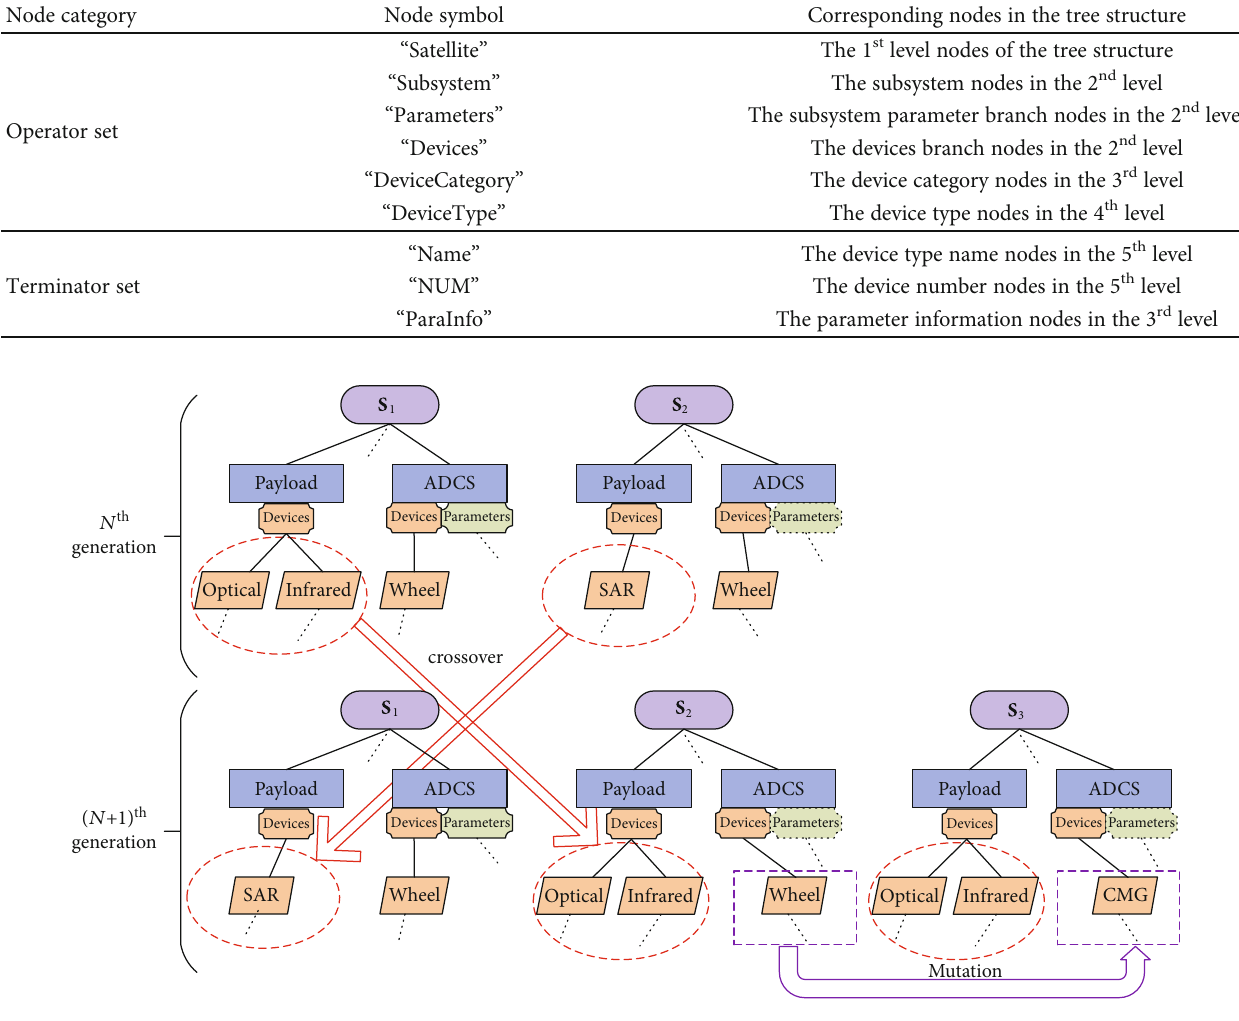
Table 1: De fi nition of operator set and terminator